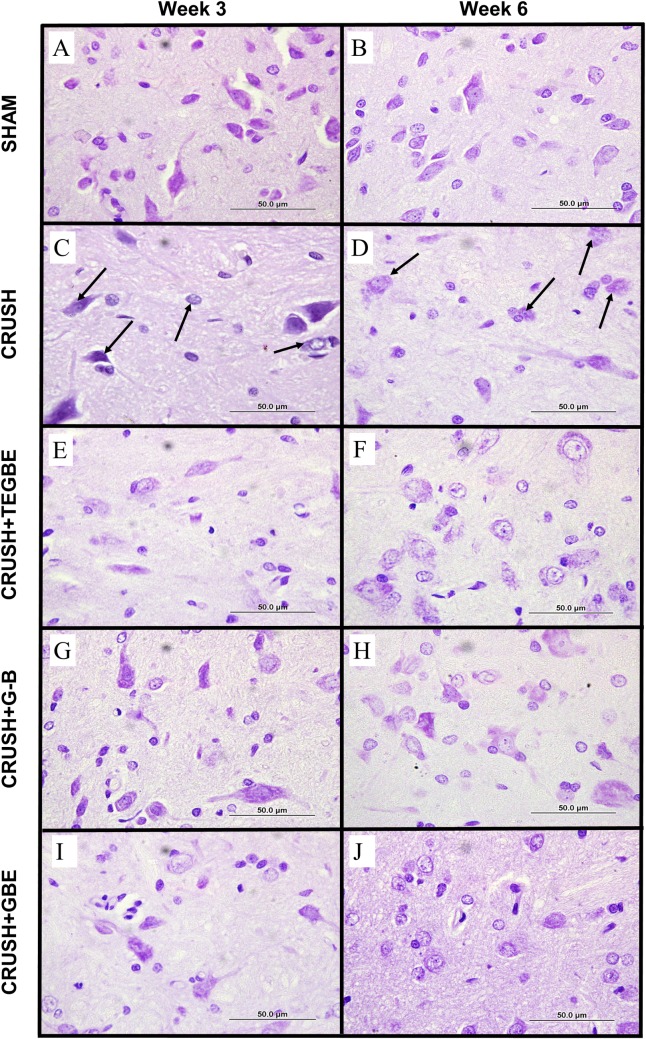
Nissl staining.Representative photomicrographs (100x objectives) of the ipsilateral dorsal horn of the L3-L6 spinal cord segments stained with cresyl violet from all groups at weeks 3 and 6 following sciatic nerve injury. Sham group (n = 12) (A, B) shows normal sensory neurons with stained Nissl bodies. Crush group (n = 12) (C, D) displays less and chromatolysed neurons compared to sham group (arrows). TEGBE (n = 12) (E, F), G-B (n = 12) (G, H) and GBE-treated (n = 6) (I, J) groups display remarkably more protected sensory neurons with normal morphology and Nissel Bodies staining compared to crush group at week 3 and week 6 post-injury.